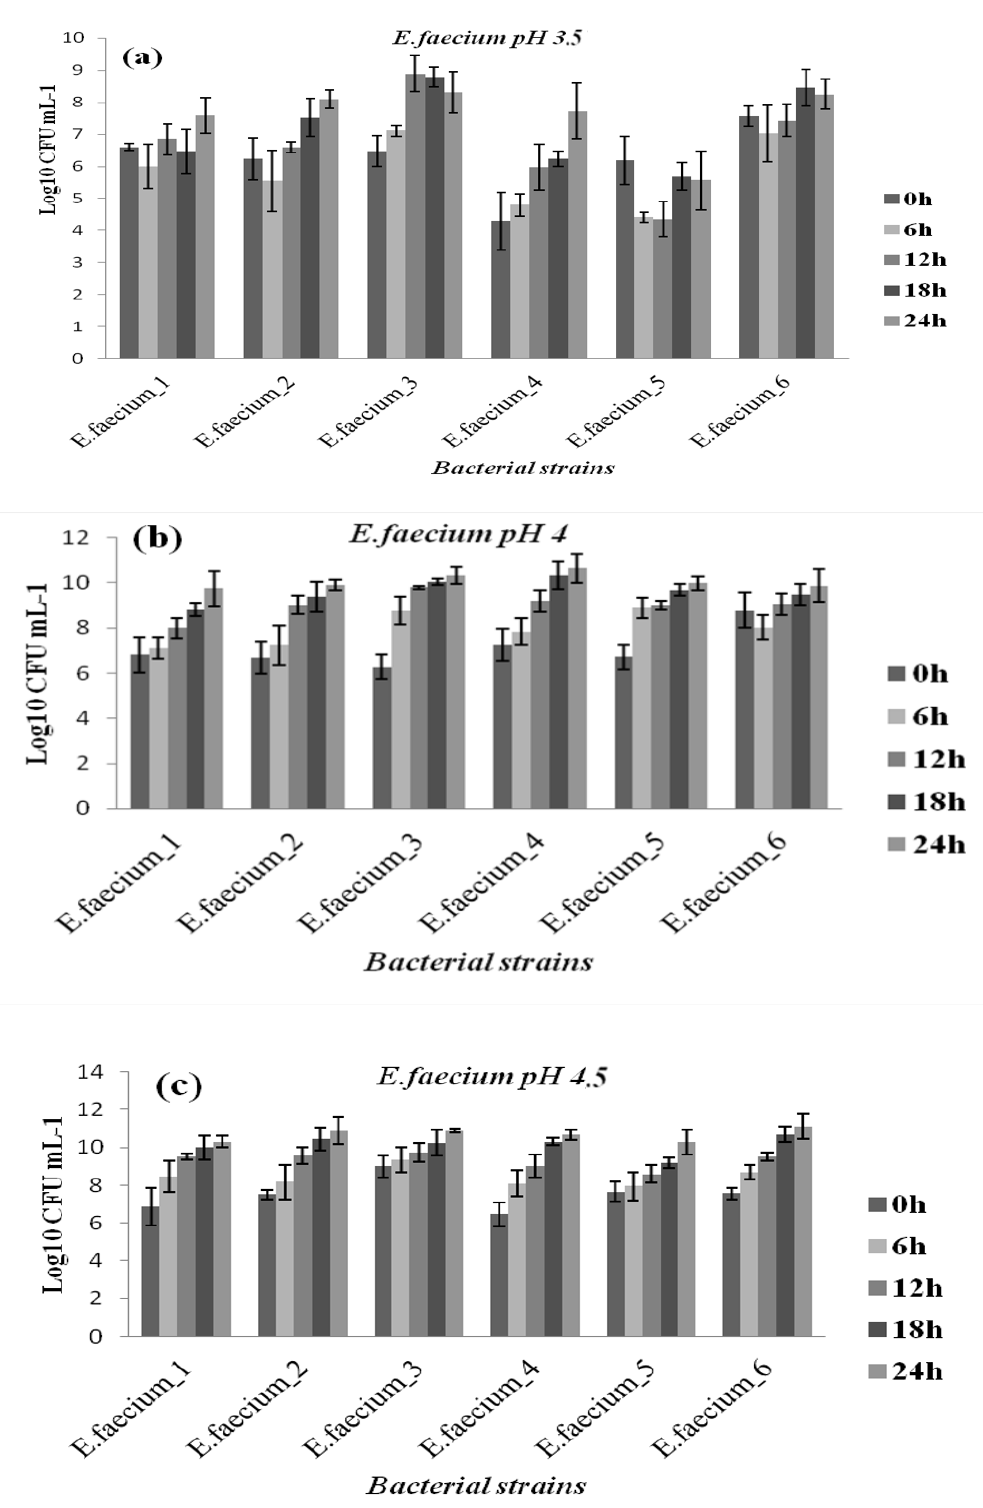
Figure 5. Growth of vaginal Enterococcus faecium strains at pH 3.5 ( a ); pH 4 ( b ); and pH 4.5 ( c ).